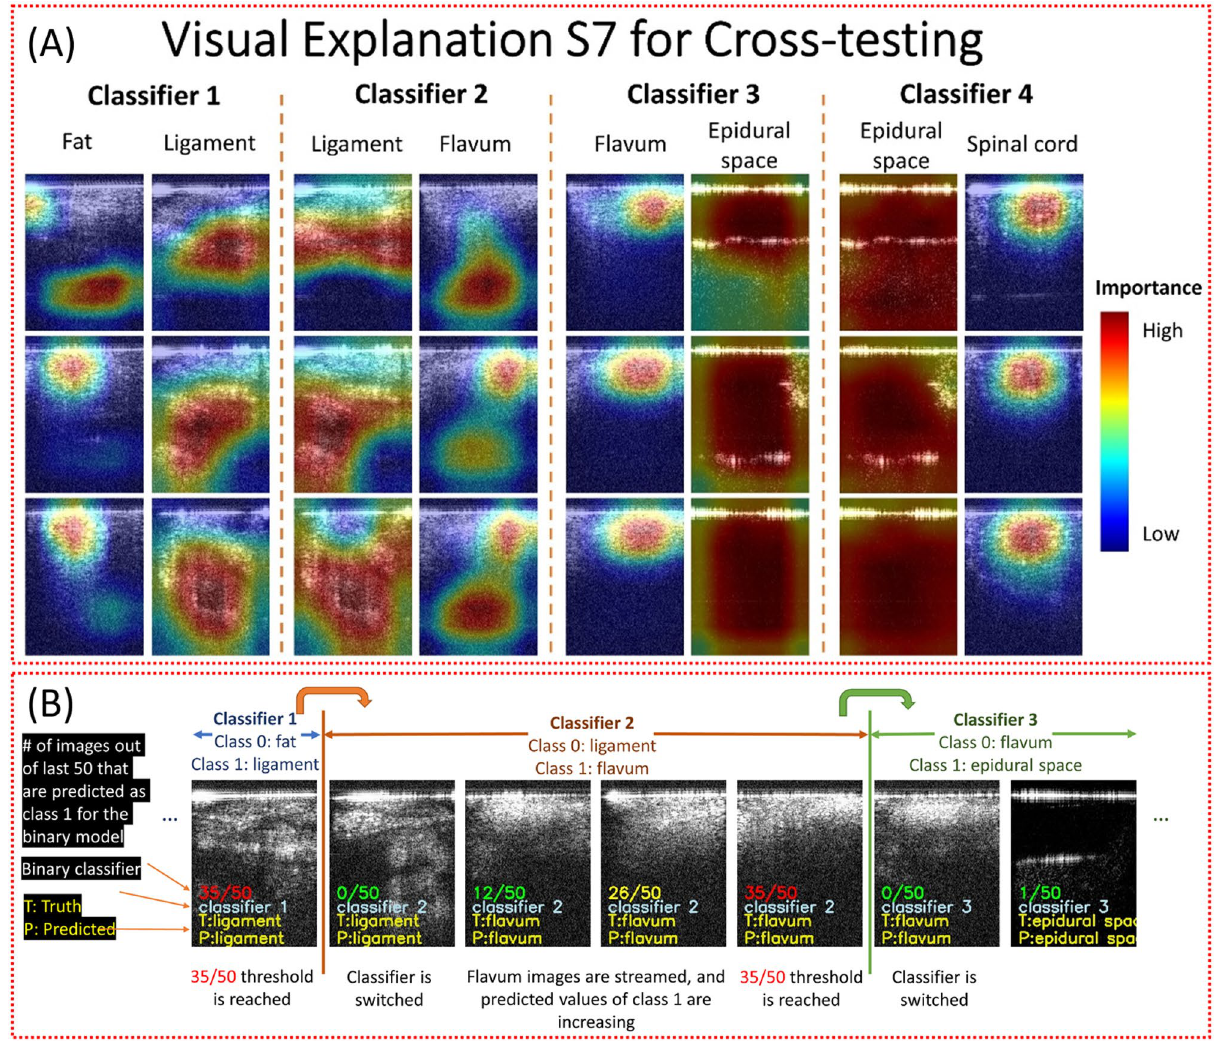
Figure 2. Class activation heatmaps for Subject 7 using ResNet50 in cross-testing ( A ) and video captures of the insertion process ( B